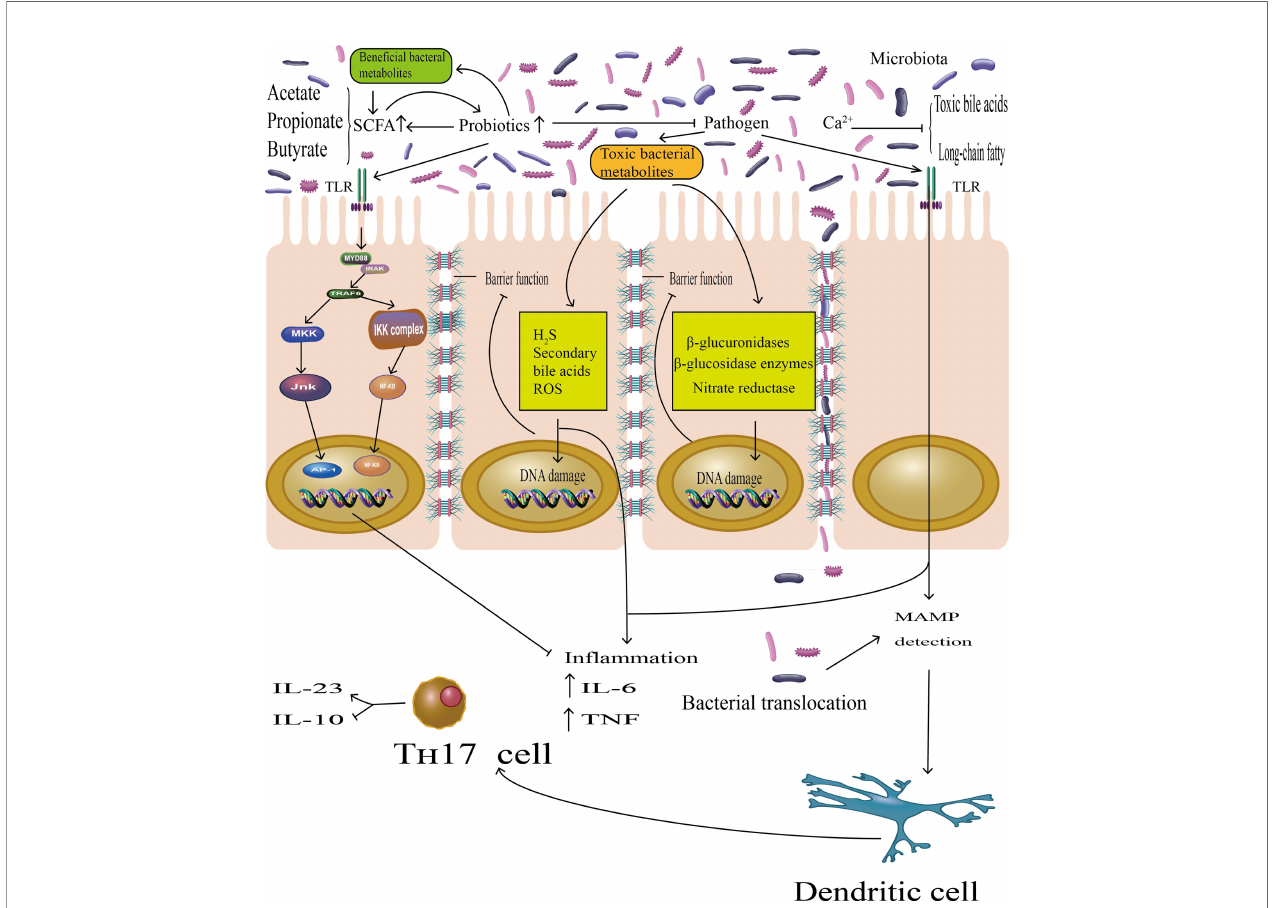
FIGURE 5 | The probiotics play essential roles in host metabolism, immune modulation, and colonization resistance to pathogens, suppressing the CRC progression. On the one hand, there were studies demonstrating that probiotics can prevent the attachment of pathogenic bacteria to gut epithelia. On the other hand, short-chain fatty acids (SCFAs), mainly acetate, butyrate, and propionate, are major metabolic products of probiotics, promoting probiotics growth and reproduction, protecting the intestinal barrier function. Probiotics may represses toxic bacterial metabolites by indirectly inhibiting the growth of pathogens. Toxic bacterial metabolites can induce DNA damage in epithelial cells; indirectly impaired barrier function was among the constellation of accepted pathologies in CRC and generated local or chronic in fl ammation by producing in fl ammatory cytokines (IL-6, TNF). In addition, pathogenic bacteria may also exert pro-in fl ammatory effects via microorganism-associated molecular patterns (MAMPs) by Toll-like receptors (TLRs), which lead to detection by dendritic cells (DC) as well as activation of Th-17 cells, and the latter will promote the expression of the pro-in fl ammatory mediator IL-23 and block the expression of the anti-in fl ammatory mediator IL-10. However, probiotics also bound the Toll-like receptor (TLR), which activated the TLR – NF-kB signal transduction pathway to inhibit the in fl ammatory